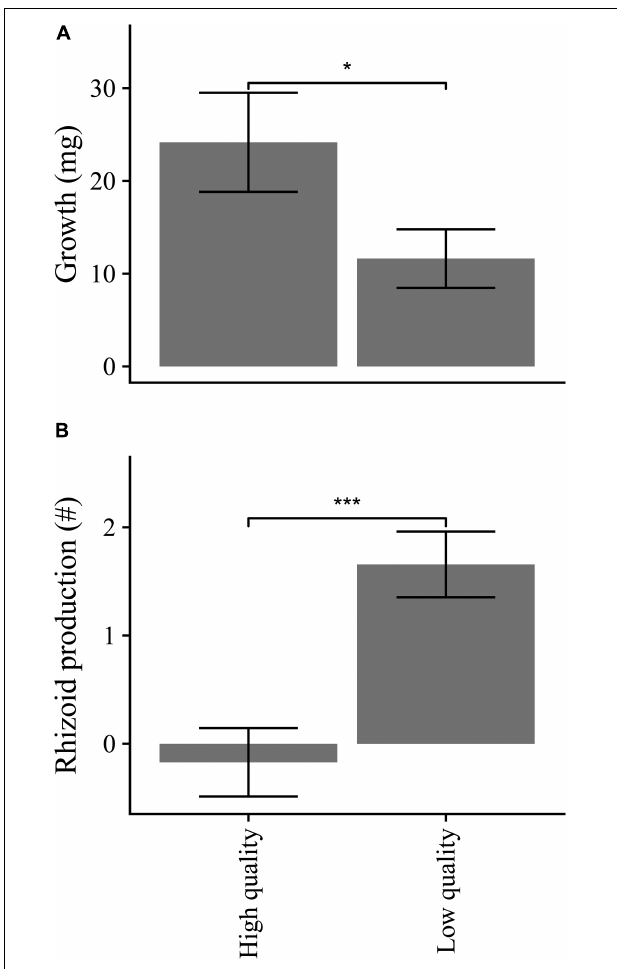
FIGURE 6 | Propagule growth (A) and production of rhizoid clusters (B) over 10-day experimental period across Propagule qualities, averaged over levels of Substrate type ( n = 35). Symbol indicates significant propagule quality effect ( Table 4 ). Error bars represent SE. * p < 0.05 and *** p < 0.001.